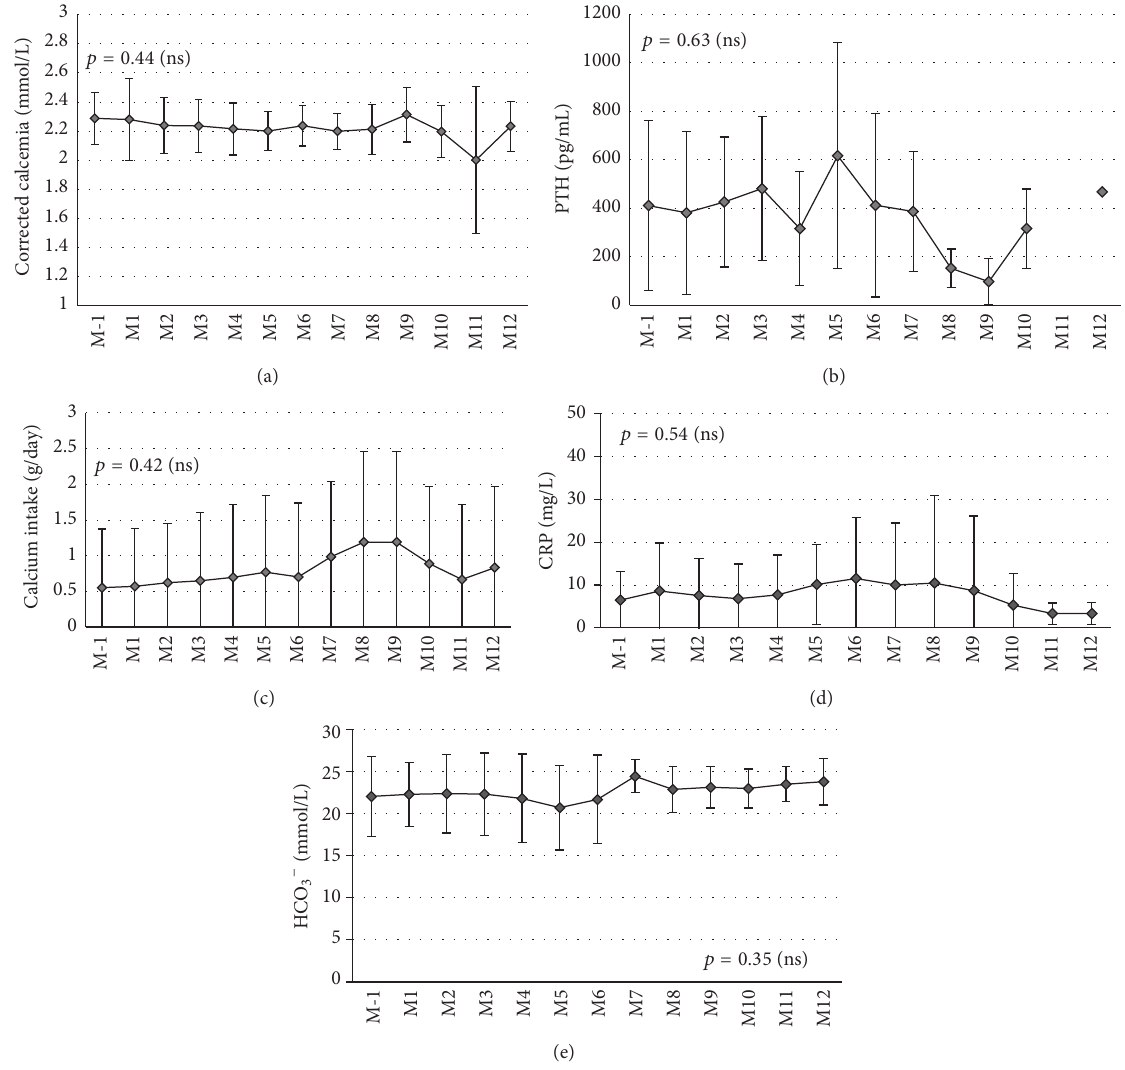
Figure 2: Comparison of different predialysis biological data between acetate dialysate (M-1) and citrate dialysate during the 12 following months (citrate only). No difference was observed in (a) corrected calcemia ( 𝑝 = 0.44 ), (b) PTH ( 𝑝 = 0.63 ), (c) calcium intake ( 𝑝 = 0.42 ), (d) CRP ( 𝑝 = 0.54 ), and (e) predialysis HCO 3− ( 𝑝 = 0.35 ). Friedman tests were applied to determine 𝑝